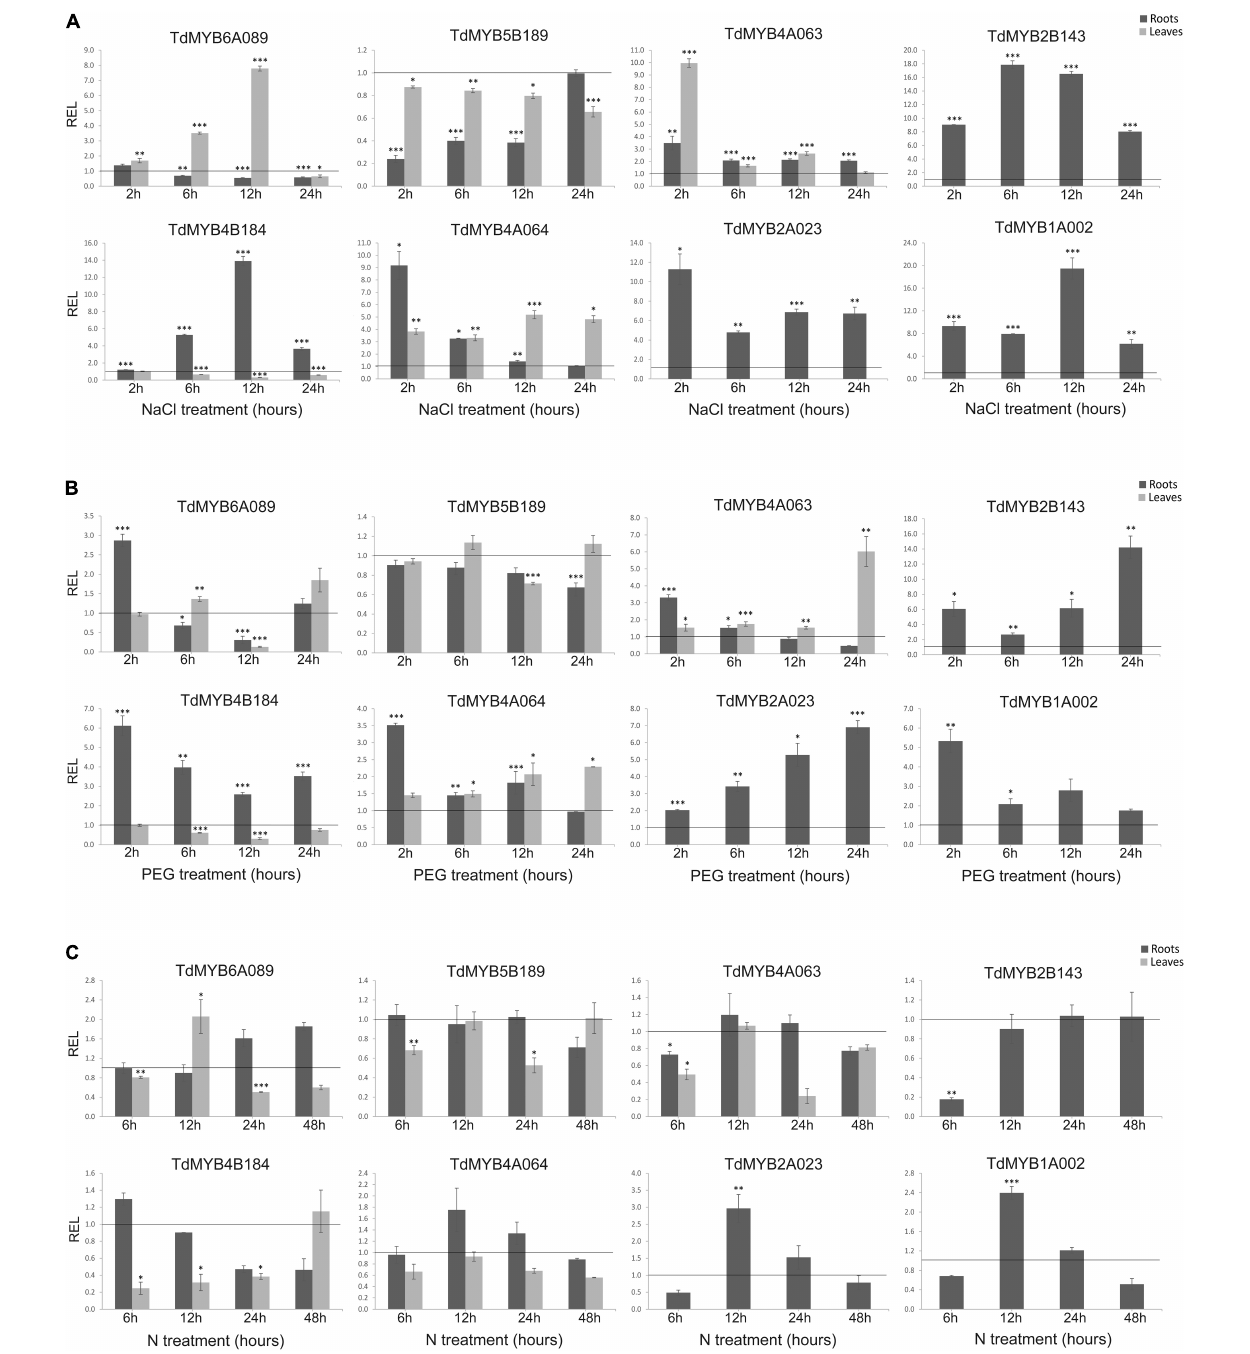
FIGURE 5 | Relative expression levels (real-time quantitative PCR) of eight R2R3-MYB genes in durum wheat roots and leaves. Plants were subjected to salt (A) , drought (B) , or nitrogen (N) deprivation (C) stress, in time course experiments. Relative expression was calculated at each time point for stressed sample with respect to the corresponding control (non-stressed sample). The control expression value at each time point is set as 1 and is represented by the black line in each graph. *, **, and *** indicate significance at p < 0.1, 0.05, and 0.01, respectively. REL, relative expression level.